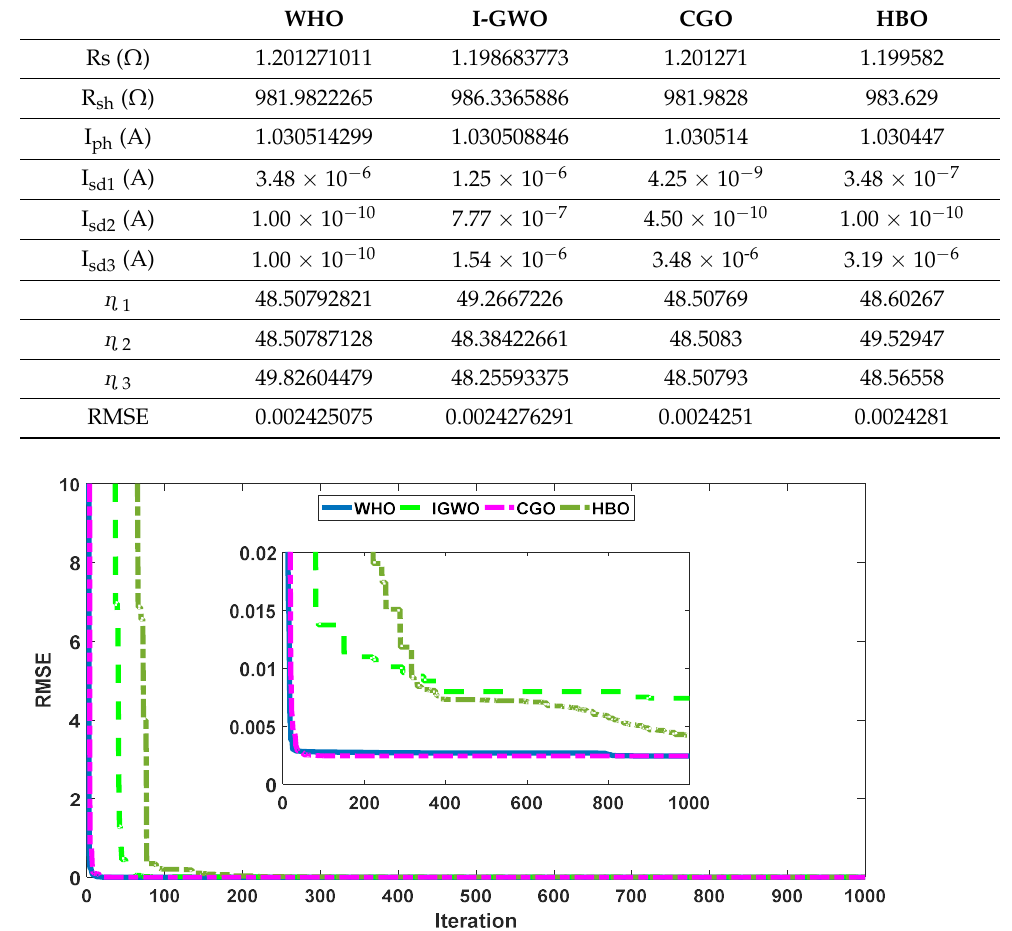
Figure 18. The convergence curve of all algorithms.